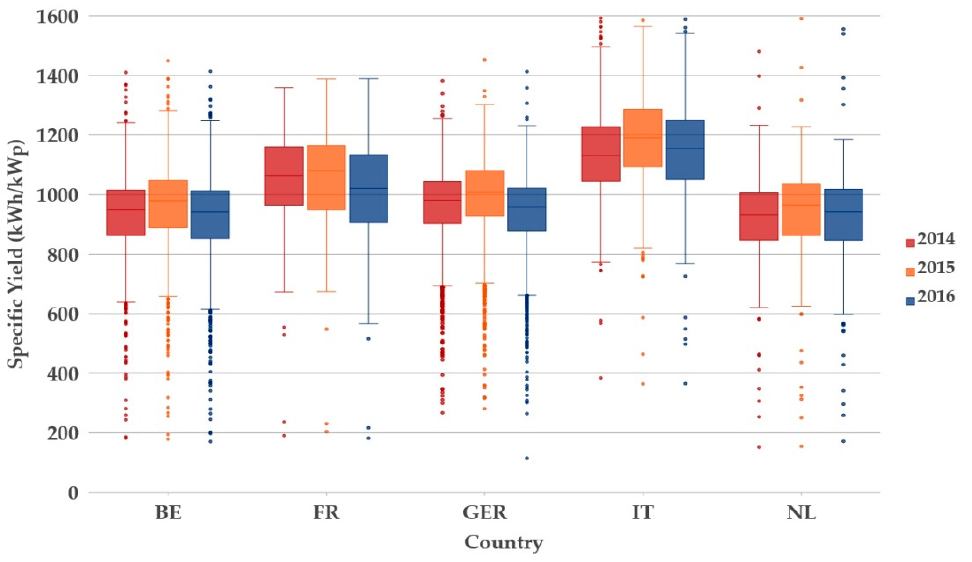
Figure 3. Distribution of specific yield by country from 2014 to 2016 for systems less than 20 kWp. Highest yields were recorded in 2015, with Italy (IT) having the highest mean, followed by France (FR), Germany (GER), Belgium (BE), and the Netherlands (NL), respectively.